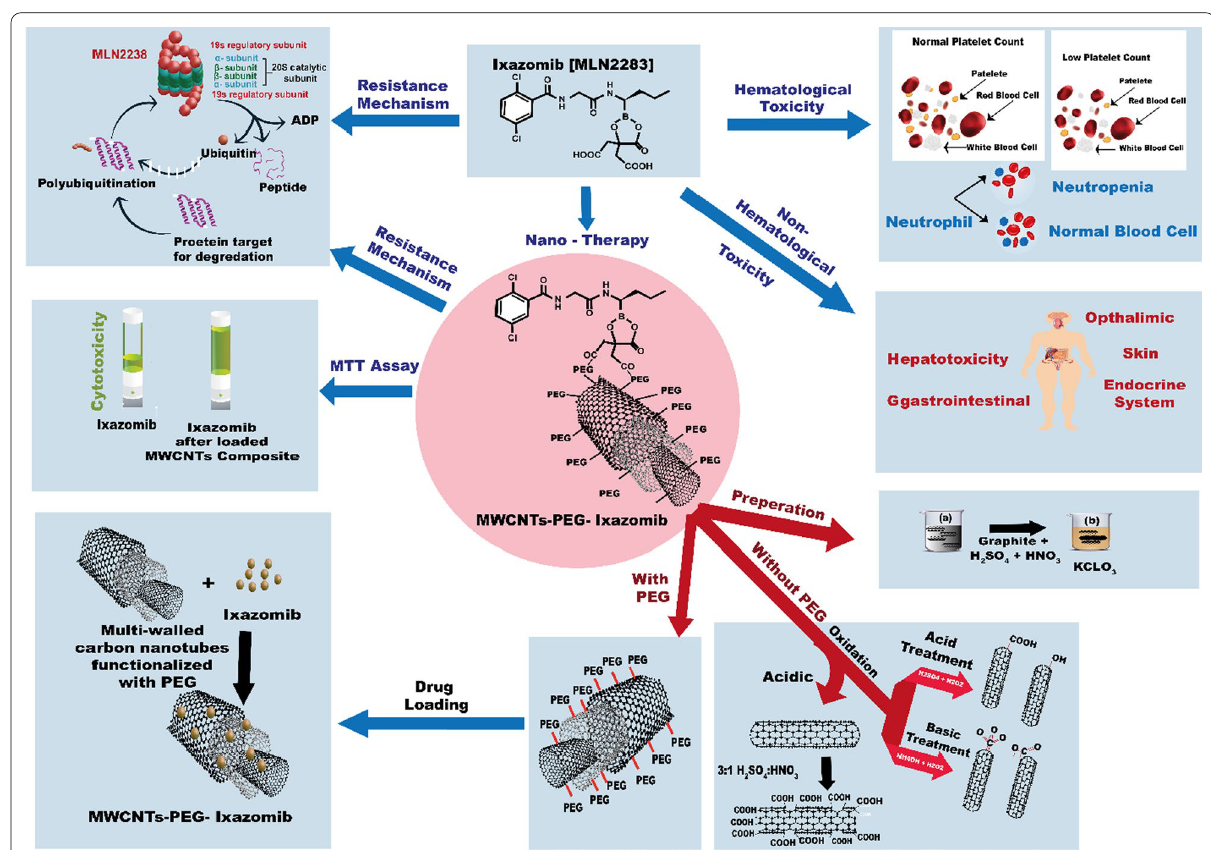
Fig. 1 a the structure of Ixazomib loaded multi-walled carbon nanotubes. b Schematic illustration of Hematological toxicity of Ixazomib on normal platelet count and neutrophil. c Schematic illustration of non-hematological toxicity of Ixazomib on human organs. d Method of preparation of multi-walled carbon nanotubes. e Mechanism of multi-walled carbon nanotubes without polyethylene glycol (PEG). f Mechanism of multi-walled carbon nanotubes with polyethylene glycol (PEG). g Schematic illustration of loading Ixazomib on multi-walled carbon nanotubes. h Cytotoxicity of Ixazomib before and after loaded MWCNT (I) Mechanism resistance of